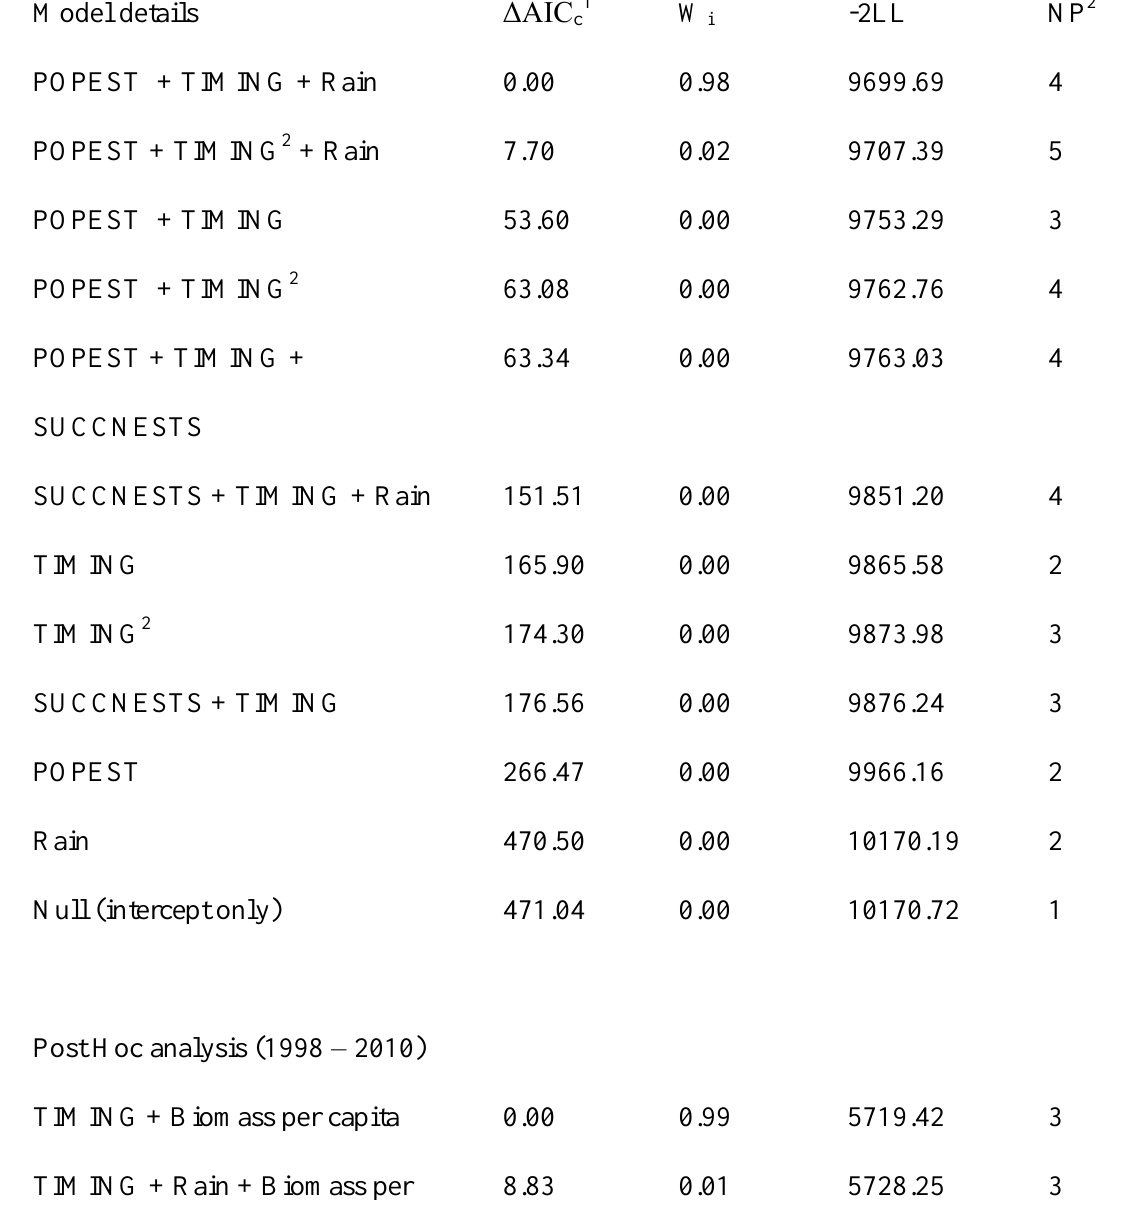
Table A1.1. List of candidate models used to evaluate gosling size at banding for Canada geese nesting on Akimiski Island, NU. All models included the random effect of brood ID. Analyses are based on 1611 measured known aged goslings. See Methods for explanation of